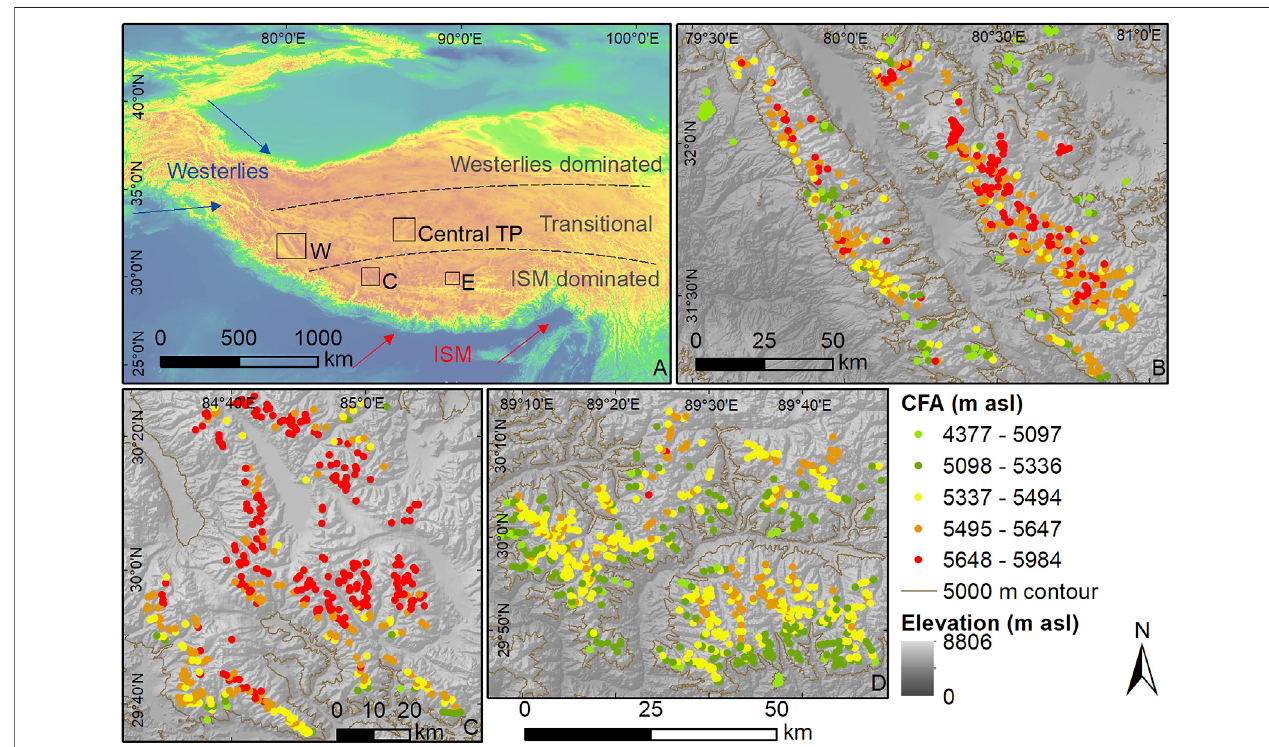
FIGURE 1 | Map of the study area: (A) Atmospheric circulations domains of the eastern (E), central (C) and, western (W) parts of the Gangdise Mountains (Thompson et al., 2018; Zhang et al., 2020), and the central Tibetan Plateau (TP) (Zhang et al., 2021); and (B) Cirque fl oor altitudes (CFAs) in the Gangdise Mountains ’ western, central (C) , and eastern (D)